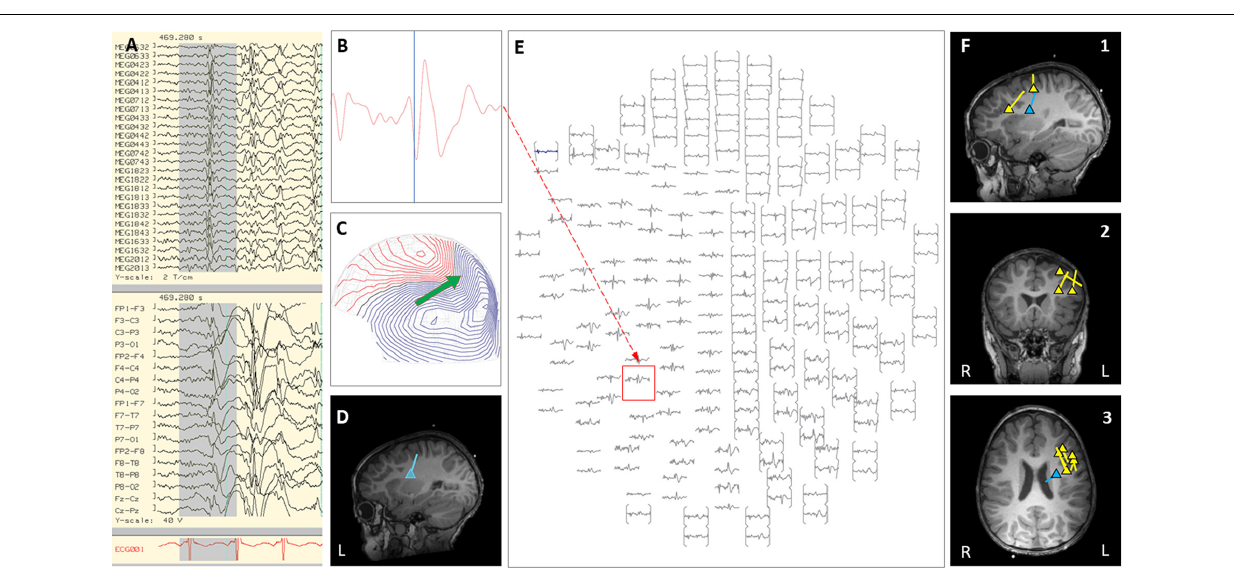
FIGURE 3 | Case 18 (A–E) an example of an individual simultaneous MEG–EEG seizure onset in the left intra-Sylvian area. (B) Selected MEG channel and time instance of the magnetic field distribution (C) in sensor space with the projected source estimate (green arrow). The sagittal MRI slices (D) indicates the origin and source orientation of the seizure onset. The MEG channel plot (E) of the selected time interval as shown in (A) shows the region of interest and the planar gradiometer channel (red square) with the earliest peak time. The summary pictures (F1–F3) give an impression of the epileptiform activity before surgery (yellow triangles) and seizure onset (blue